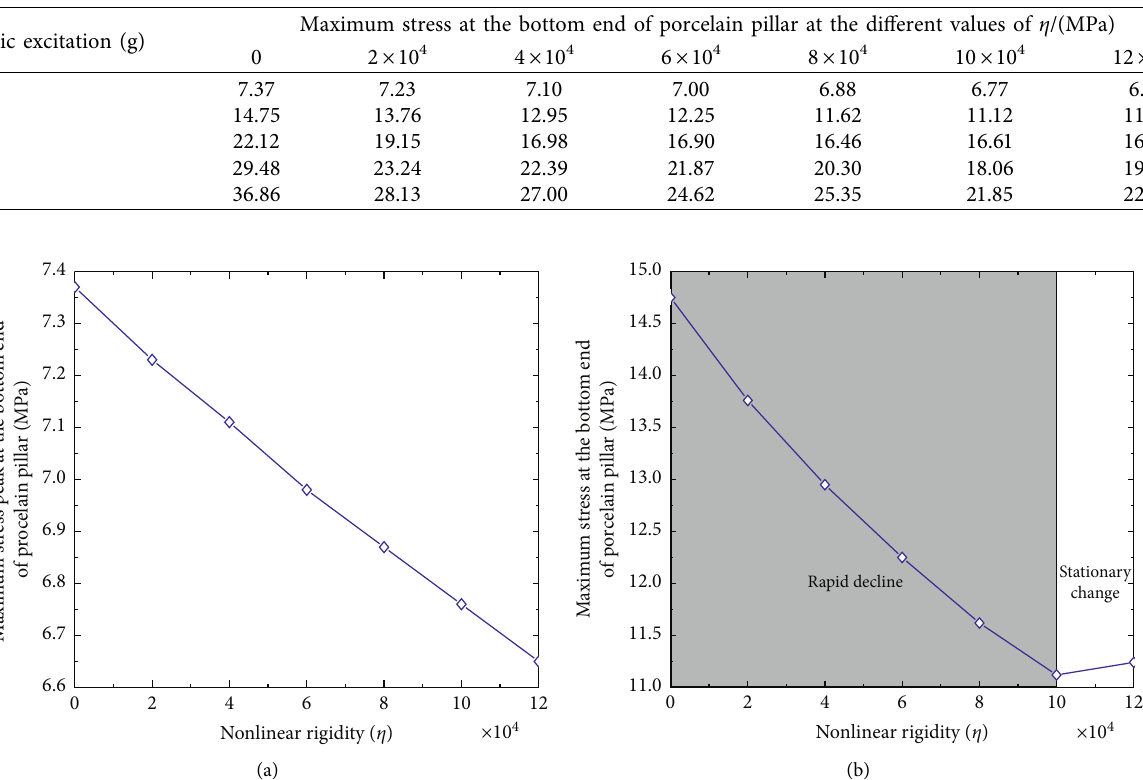
Figure 26: Curves of the relation between different seismic excitations and equipment dynamic response. Table 3: Maximum stress value at the bottom end of porcelain pillar with the change of nonlinear rigidity under different seismic